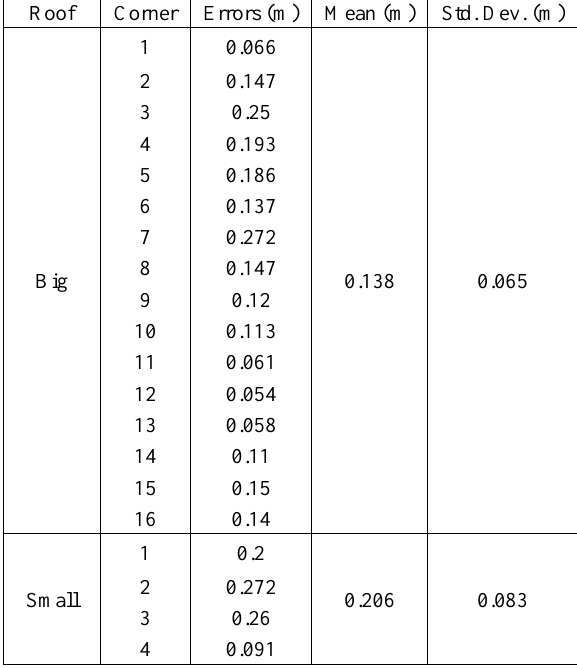
Table 1. Quantitative